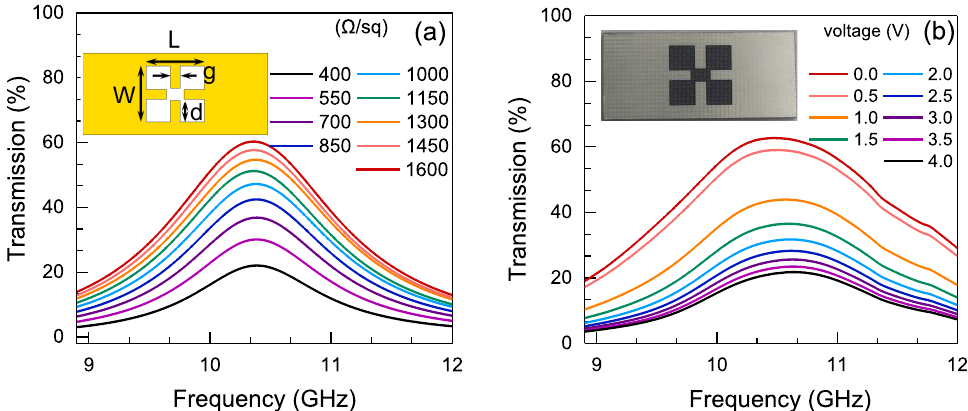
Fig. 4. (a) Calculated and (b) measured transmission spectra of the hybrid metasurface with metallic “ butter fl y ” -like pattern by changing the sheet resistance from 400 to 1600 V sq (cid:3) 1 , the external bias voltage changes from 0 to 4 V in experiments. The inset in (a) shows the schematic of the “ butter fl y ” -like structure and the inset in (b) shows a fabricated sample. The geometric parameters are: